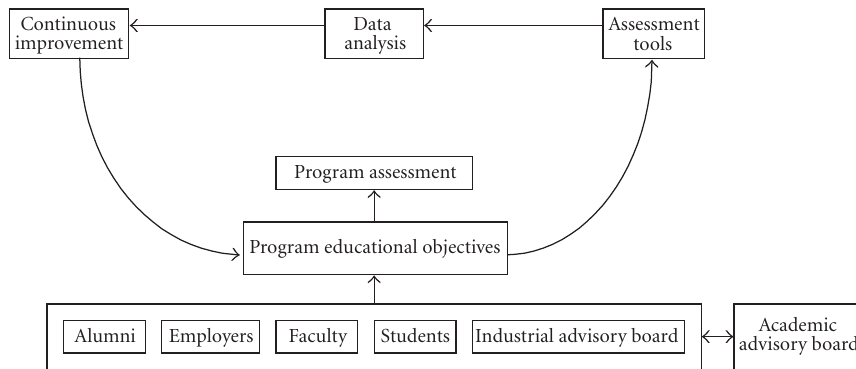
Figure 1: Program assessment